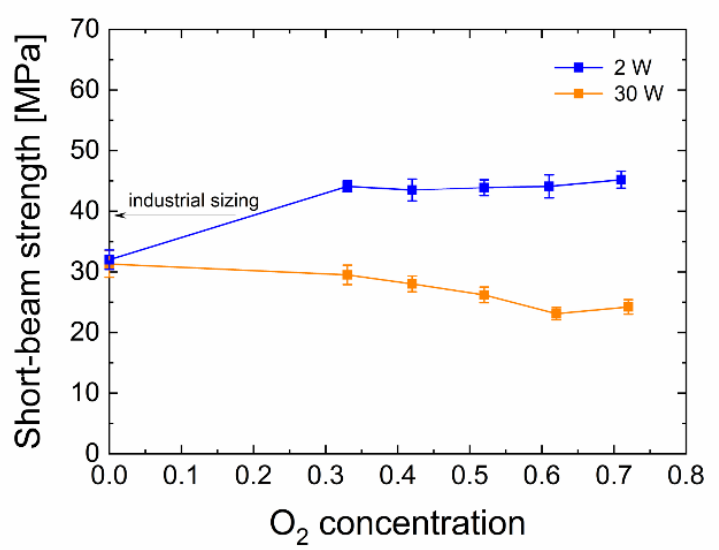
Figure 3. The relationship between short-beam strength and oxygen concentration in the TVS/O 2 mixture for two different powers. The arrow indicates the short-beam strength value of the GF/polyester composite with industrially sized glass fibres.